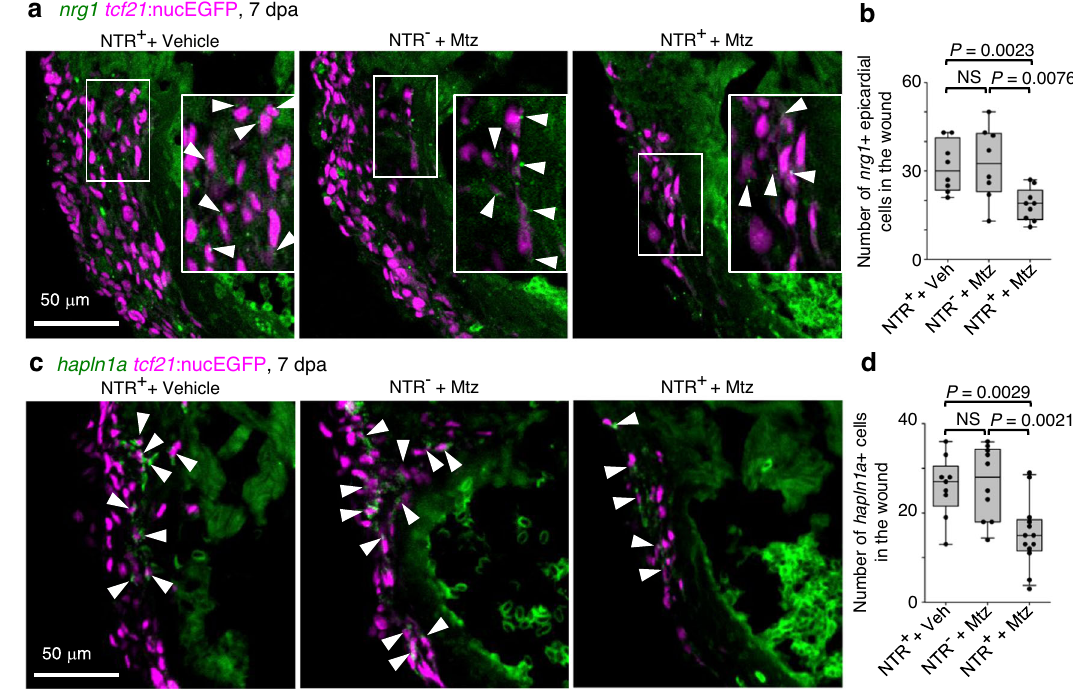
Fig. 8 | aEPC ablation reduced nrg1 and hapln1a expression in the wound. a Section images of the injury site showing HCR staining of nrg1 in green and tcf21 :nucEGFP in magenta. The framed regions are enlarged to show details with arrowheads denoting representative nrg1 + EGFP + cells. Scale bar, 50 μ m. b Quanti fi cationof nrg1 + epicardialcellsinthewoundregionsshownin a .Fromleft toright, n =8,8,and 9, respectively. NS,notsigni fi cant.Two-tailed Student ’ s t test. c Section images of the injury site showing HCR staining of hapln1a in green and